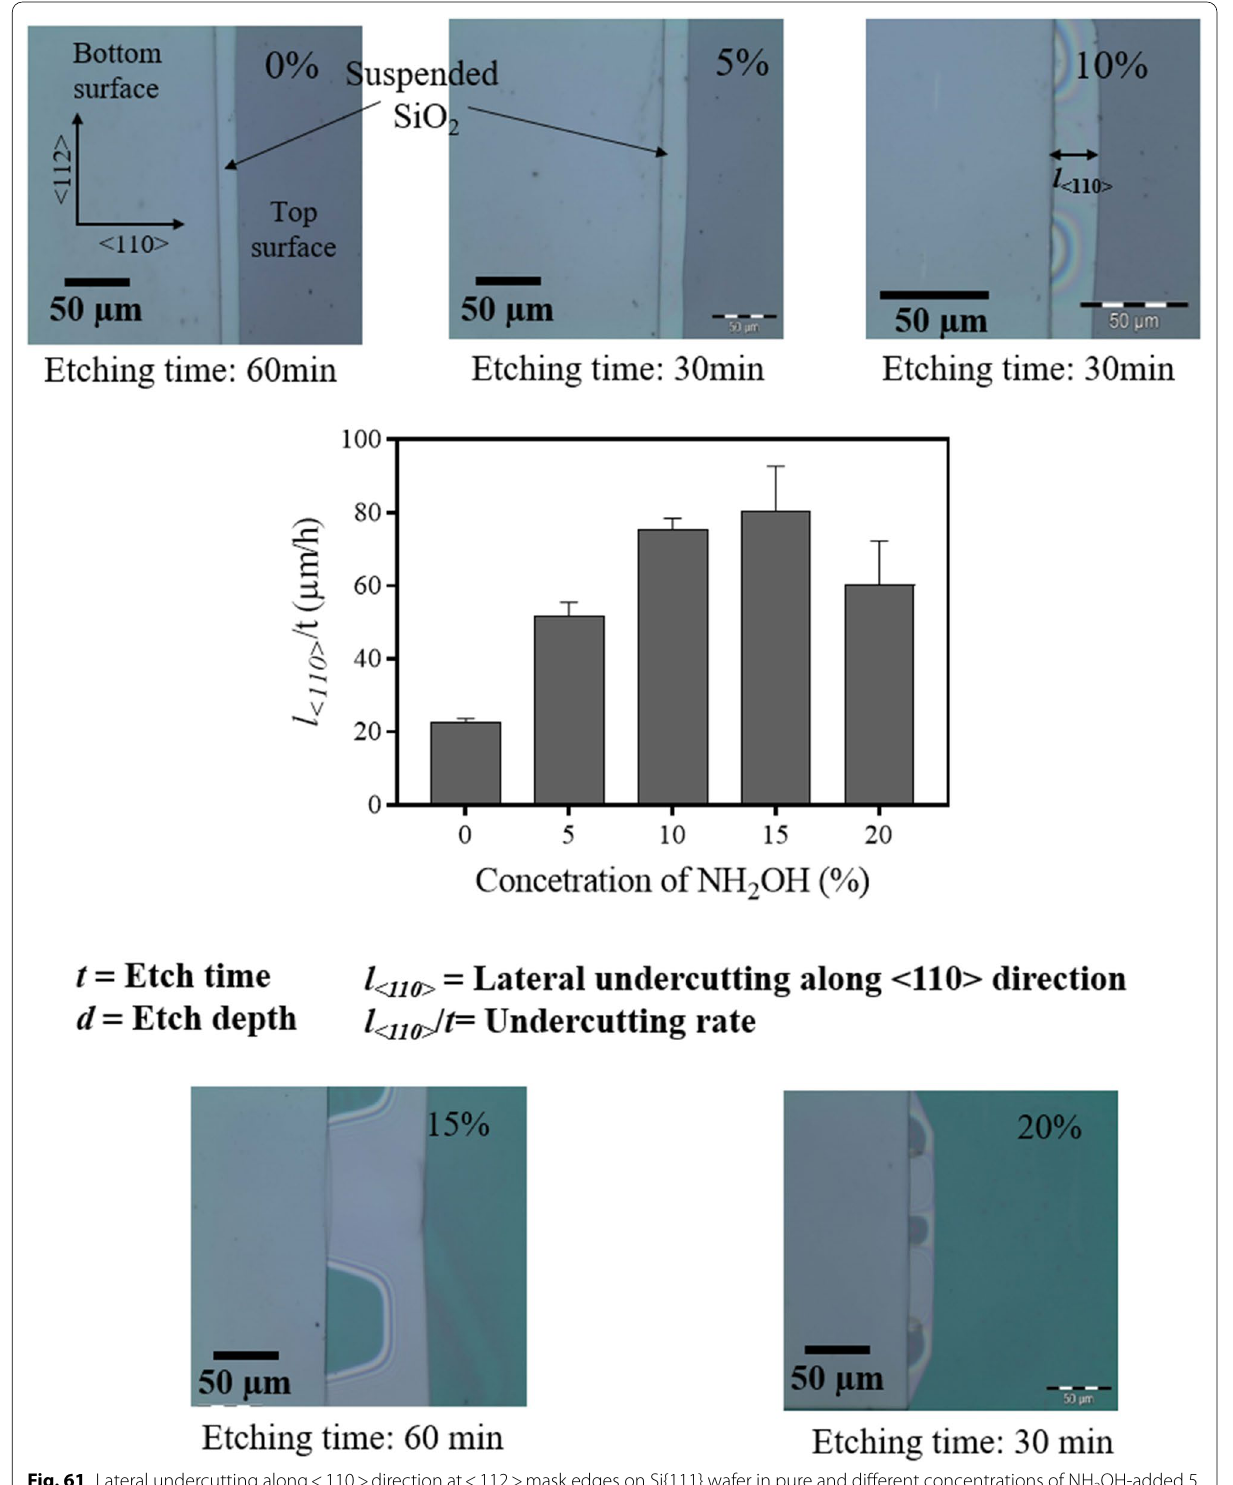
Fig. 61 Lateral undercutting along < 110 > direction at < 112 > mask edges on Si{111} wafer in pure and different concentrations of NH 2 OH-added 5 wt% TMAH at 70 1 °C ±